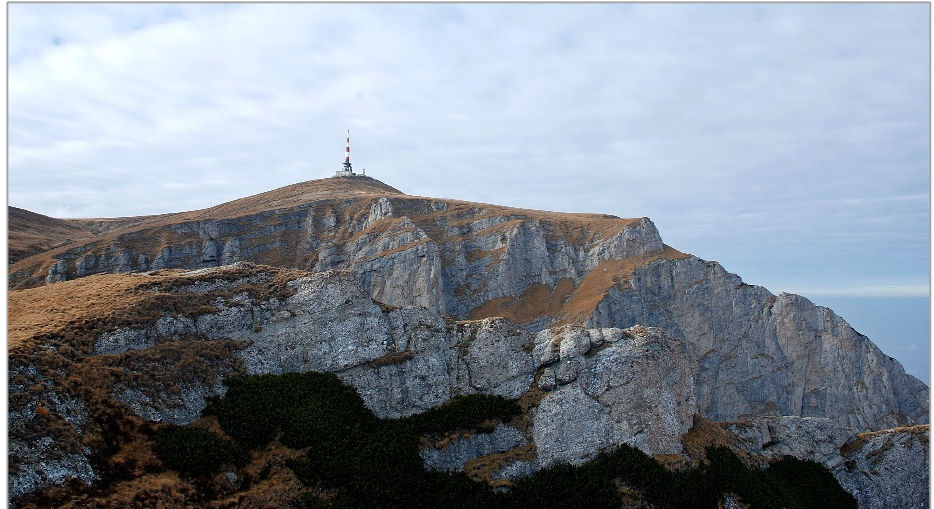
Figure 1. Bucegi Mountains—Co ș tila Peak (2490 m), with an 80 m high communication mast, making it the highest artificial point in Romania, on top of Abruptul Prahovean and part of the upstanding syncline eastern ridge (Photo: B. Olariu).